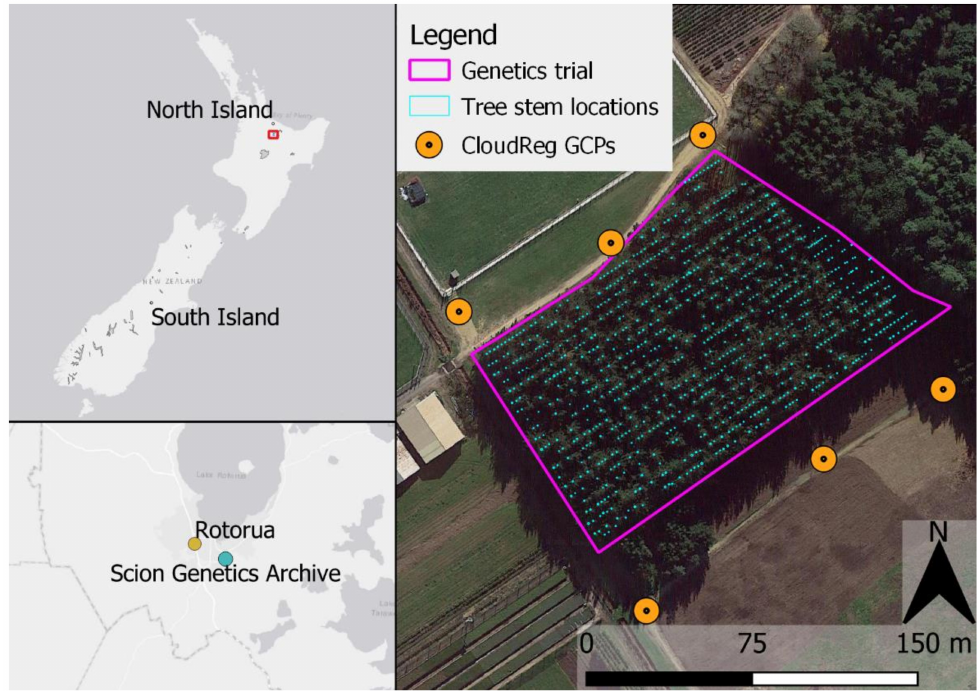
Figure 1. Map of the study site showing the area of the trial stand (purple box) and the locations of tree stems in the study (blue rings). Insets show the location of the trial site.